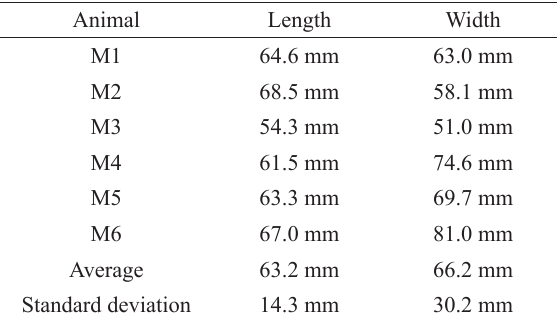
Biometric values of diaphragm muscle in Saimiri